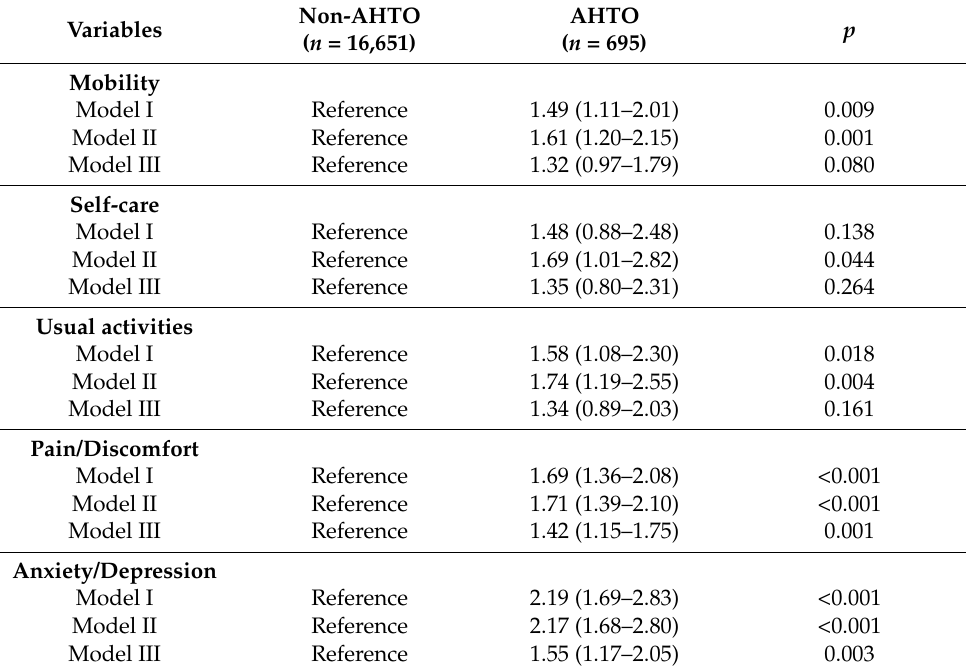
Table 3. Odds ratio (95% CI) of having problems in each dimension of the EQ-5D, based on the experiences of